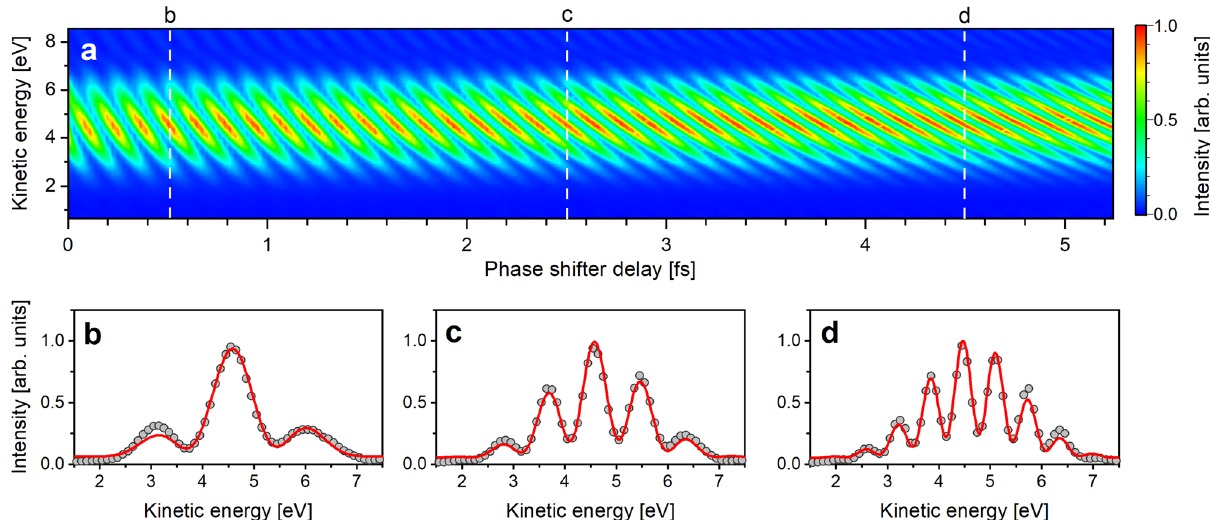
Figure 3. Time-domain photoelectron interferogram. ( a ) The photoelectron interferogram consists of photoelectron spectra measured as a function of the phase shifter delay. ( b – d ) Photoelectron spectra obtained at phase shifter delays of 0.51, 2.50, and 4.52 fs (vertical dashed lines in a ). The photoelectron spectra are fitted by Eq. (3). The experimental data points and fitting curves are shown by gray circles and red curve, respectively, in ( b – d